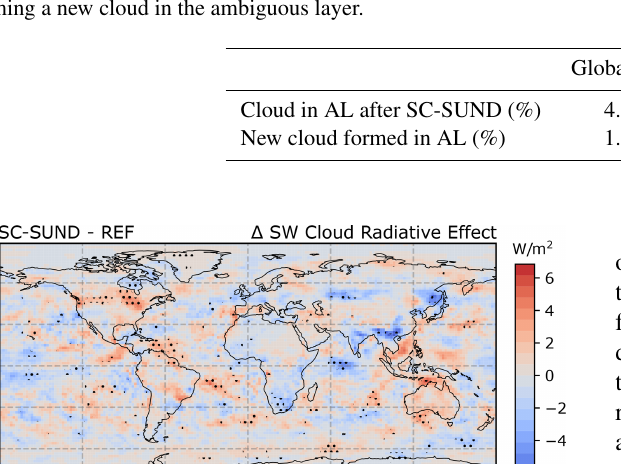
Figure 9. Presence of a cloud in the ambiguous layer in the SC-SUND simulation: (a) frequency (cf. Fig. 7c) and (b) frequency increase compared with prior to the application of SC-SUND. Table 4. Global and regional averaged occurrence frequency in the SC-SUND simulation of having a cloud in the ambiguous layer and of forming a new cloud in the ambiguous layer.